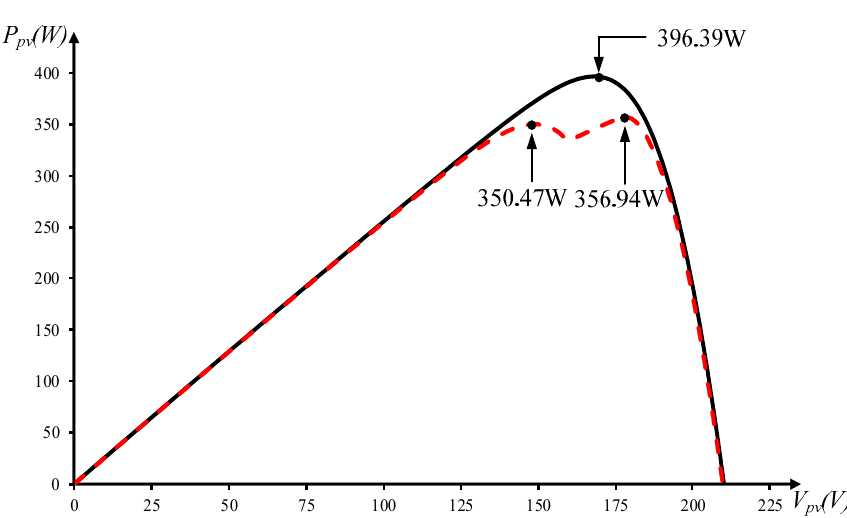
Figure 13. Output P–V curve of Case 4 photovoltaic module array.